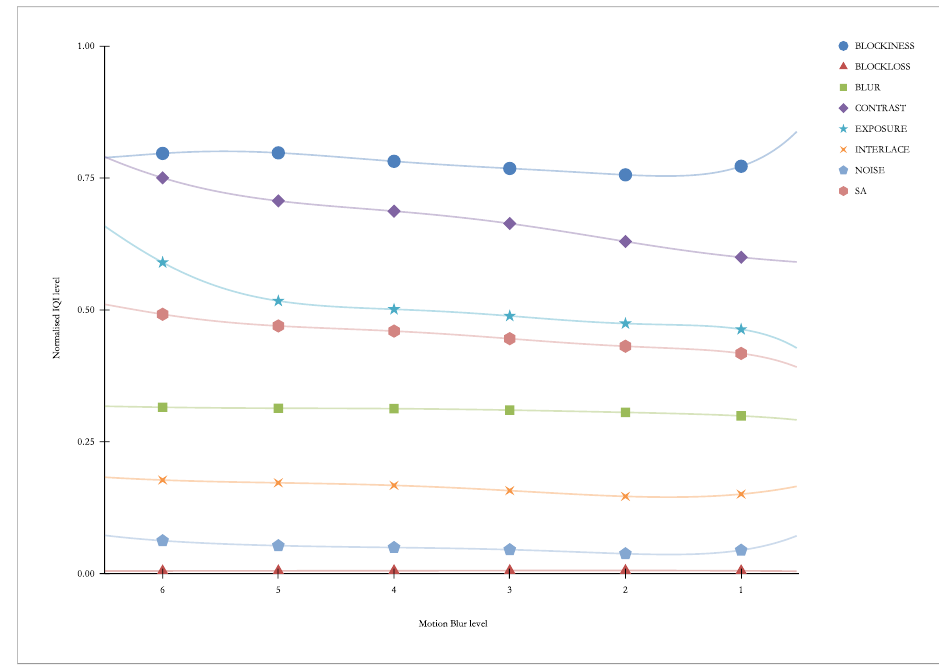
Figure 19. “Our” indicators vs. Motion Blur [ σ /degrees].